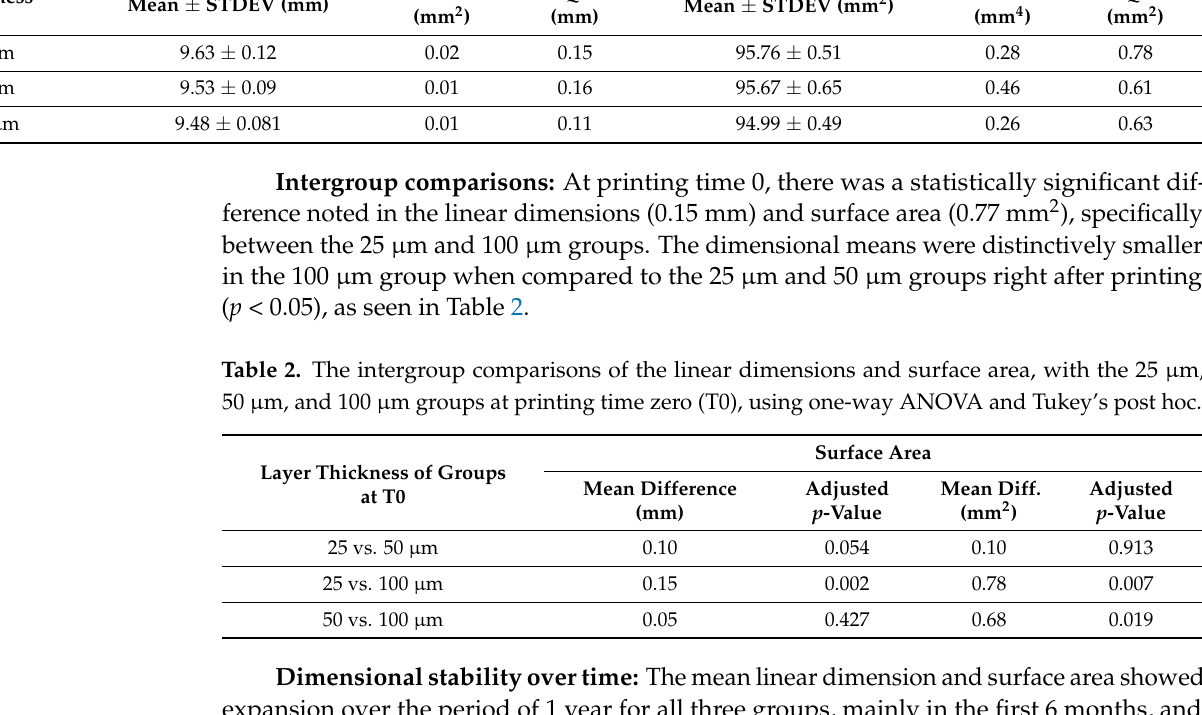
Table 1. The intragroup repeatability of the linear dimensions and surface area. Standard deviation: STDEV; interquartile range: IQR; mesial–distal width: M–D; time 0: T0; variance: V. Linear Dimension Layer Thickness